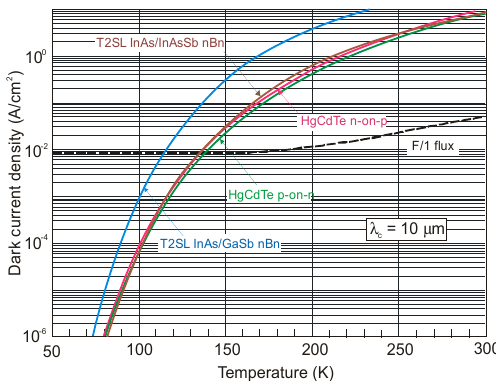
Figure 53. Dark current density versus temperature for T2SL nBn detectors and HgCdTe photodiodes with a λ cut-off = 10 μ m.